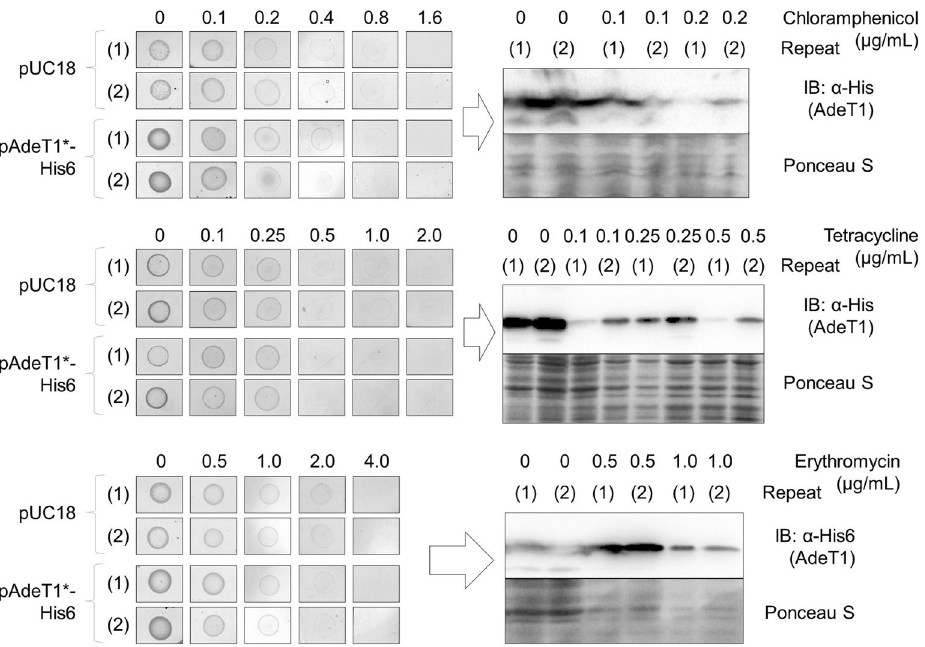
Figure 8. Antibiotic susceptibility of E. coli KAM32 carrying either pUC18 or pAdeT1*-His6. Data of two biological replicates (i.e. independent transformations), (1) and (2), are shown. E. coli KAM32 carrying either pUC18 or pAdeT1*-His6 were cultured to OD 600 0.6 before induction with 0.5 mM IPTG. After 2 h, a defined amount of cells were dropped on agar plates containing 0.5 mM IPTG, 100 µg/mL ampicillin and varying concentrations of chloramphenicol (top), tetracycline (middle) or erythromycin (bottom). Plates were incubated at 37 °C for 18 h before colonies of E. coli KAM32 carrying pAdeT1*-His6 were analysed by immunoblotting to confirm protein expression. Full-length blots are shown in Supplementary Figs. S12 and